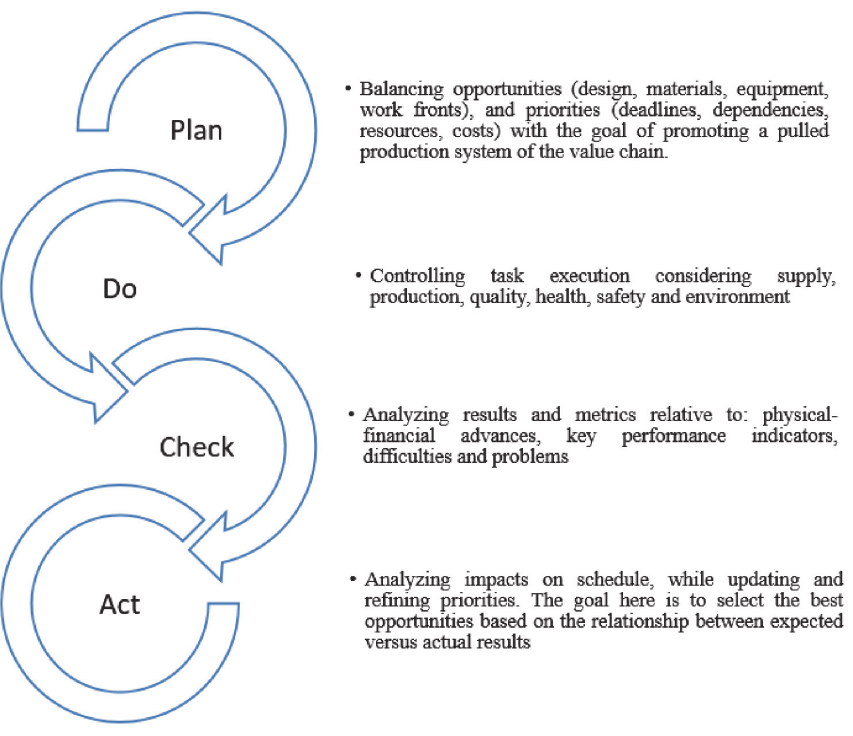
Figure 2. Standard operational procedure of Digital Obeya Room